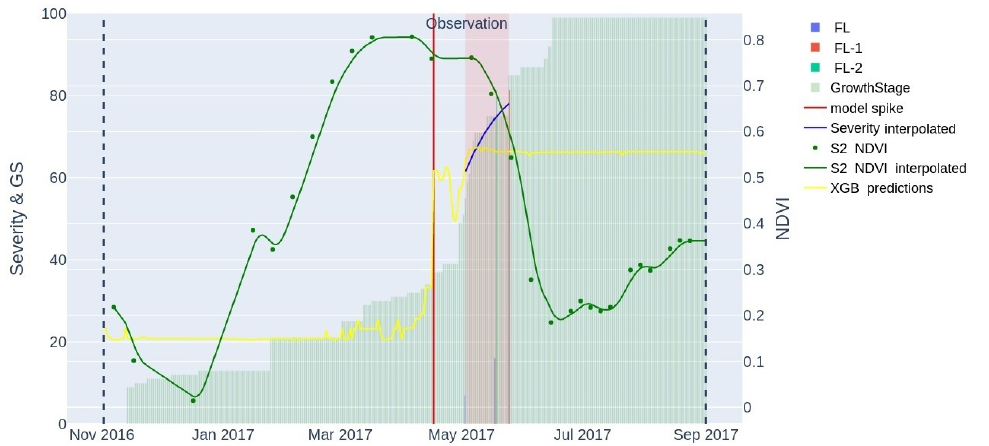
Figure 12. The predictions from weather feature-based XGBoost model (XGB predictions) showing a spike in the predicted yellow rust severity. The spike in this trial occurs around 15 days before the first actual in situ observation. The NDVI (S2 NDVI interpolation) also starts dropping after the model spike.